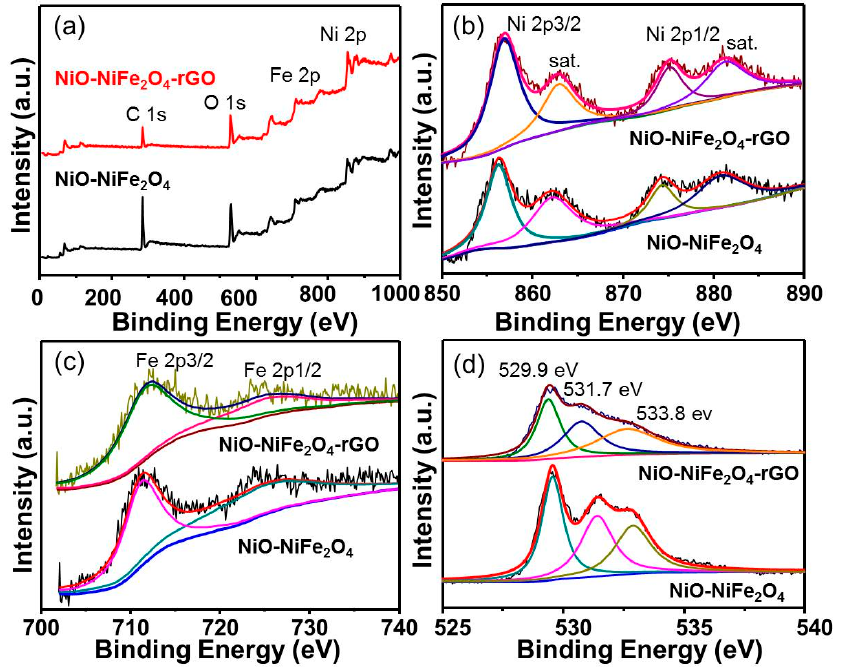
Figure 5. ( a ) X-ray photoelectron spectroscopy (XPS )spectrum, ( b ) Ni 2p XPS spectrum, ( c ) Fe 2p XPS spectrum, ( d ) O 1s XPS spectrum of NiO-NiFe 2 O 4 , and NiO-NiFe 2 O 4 -rGO.